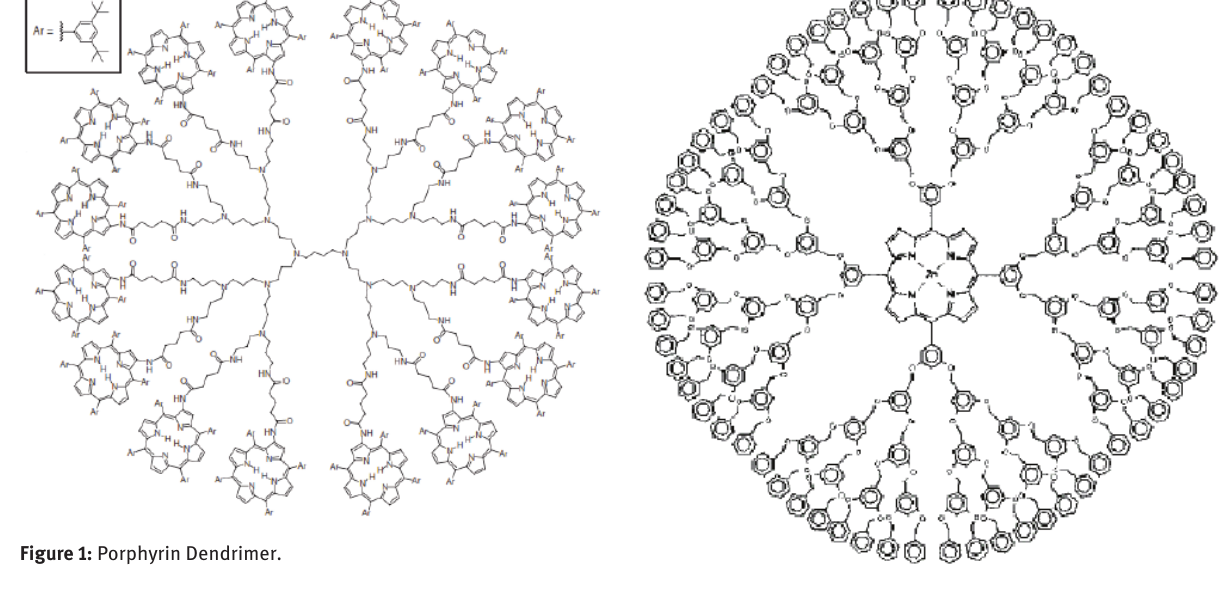
Figure 3: Zinc-Porphyrin Dendrimer.